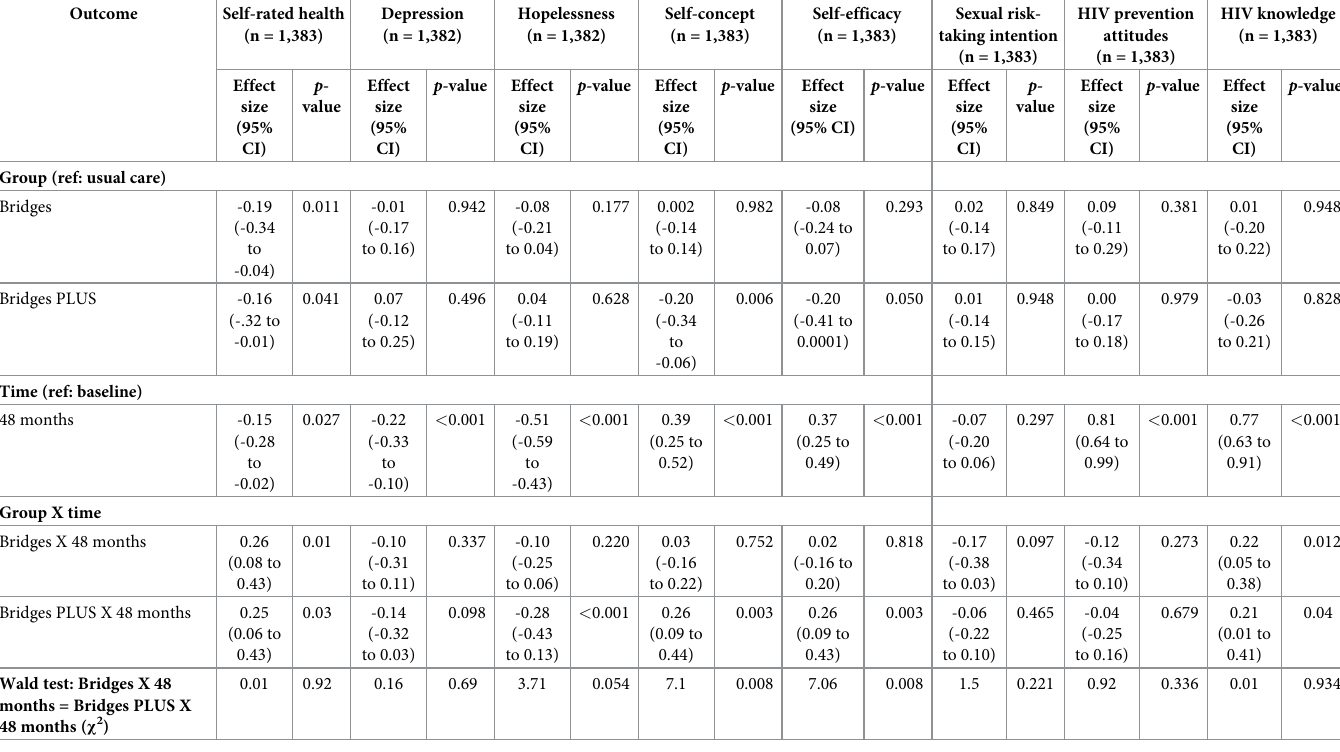
Table 2. Intervention effects on self-rated health, mental health functioning, and sexual health. Outcome Self-rated health (n =